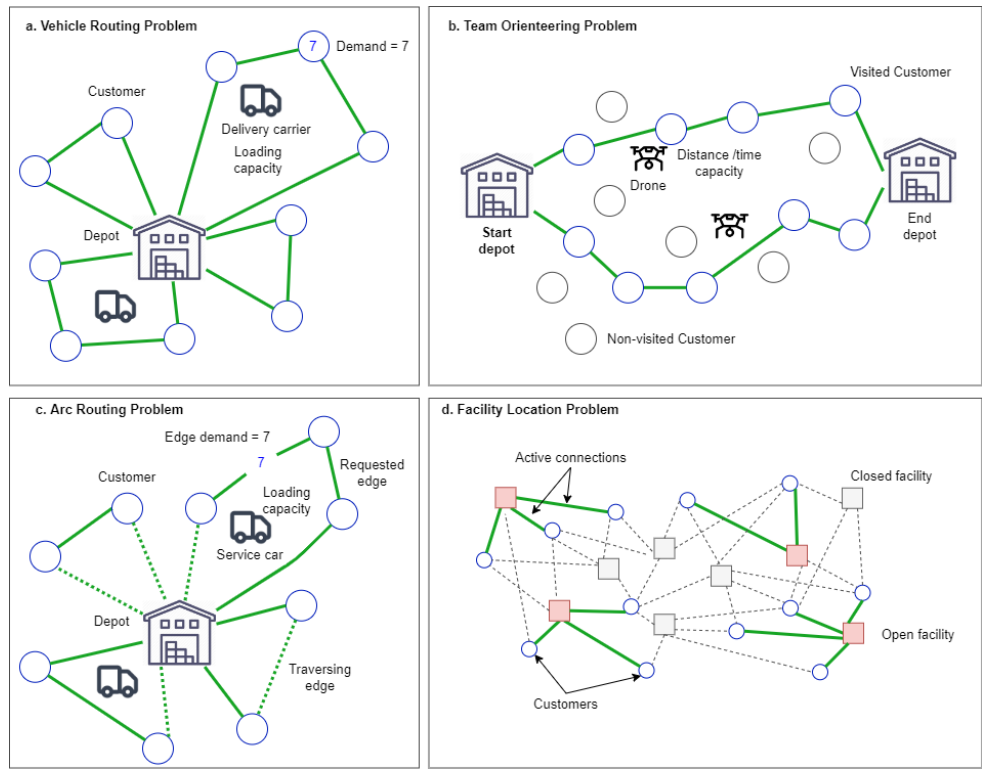
Figure 5. Illustrative examples of the main addressed problems with AO in